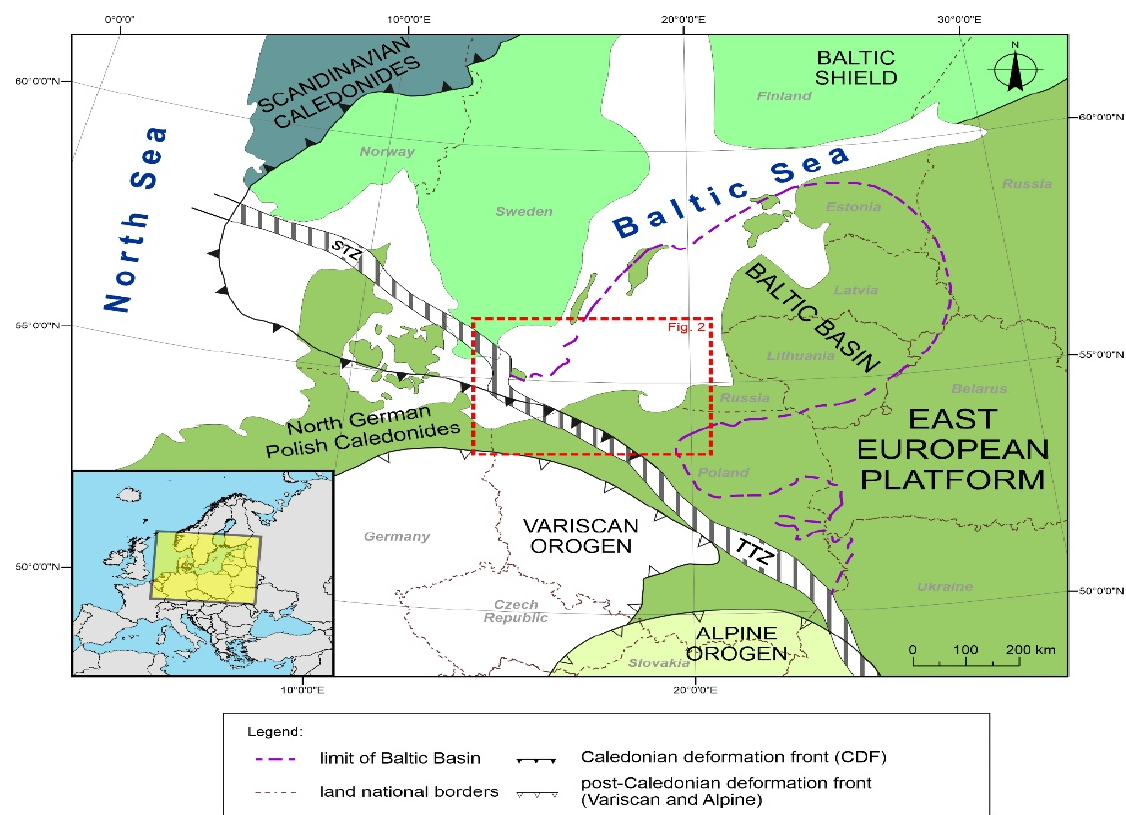
Figure 1. Location of the Baltic Basin in the East European Craton (after [10]). Dashed purple line—boundary of Baltic Basin, toothed black lines—boundaries of Caledonide, Variscan and Alpine orogens, TTZ—Teisseyre-Tornquist Zone [11], STZ—Sorgenfrei-Tornquist Zone [11]. Red dashed rectangle marks the study area.